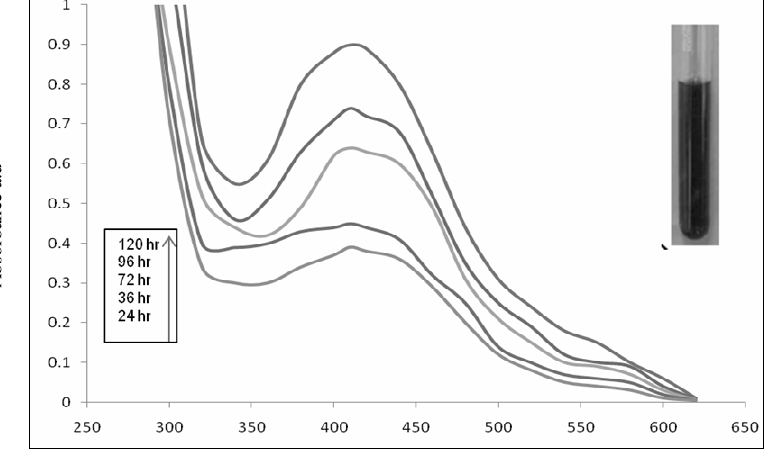
Figure 1. UV-Vis spectra recorded as a function of time of reaction of 1 mM aqueous solution of AgNO with Bacillus subtilis culture supernatant. The inset of the figure shows a 3 test tube of the silver nanoparticle solution formed at the end of the